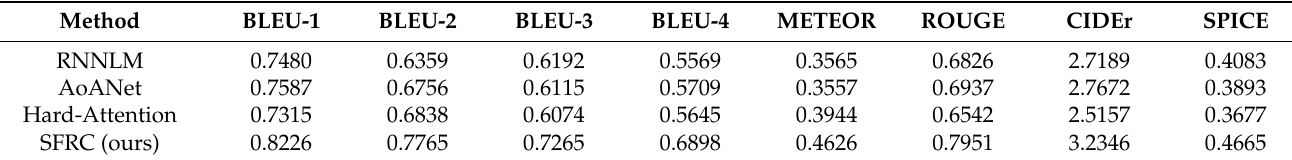
Table 7. Comparison of evaluation metric scores of methods on 60% UCM-Captions dataset.